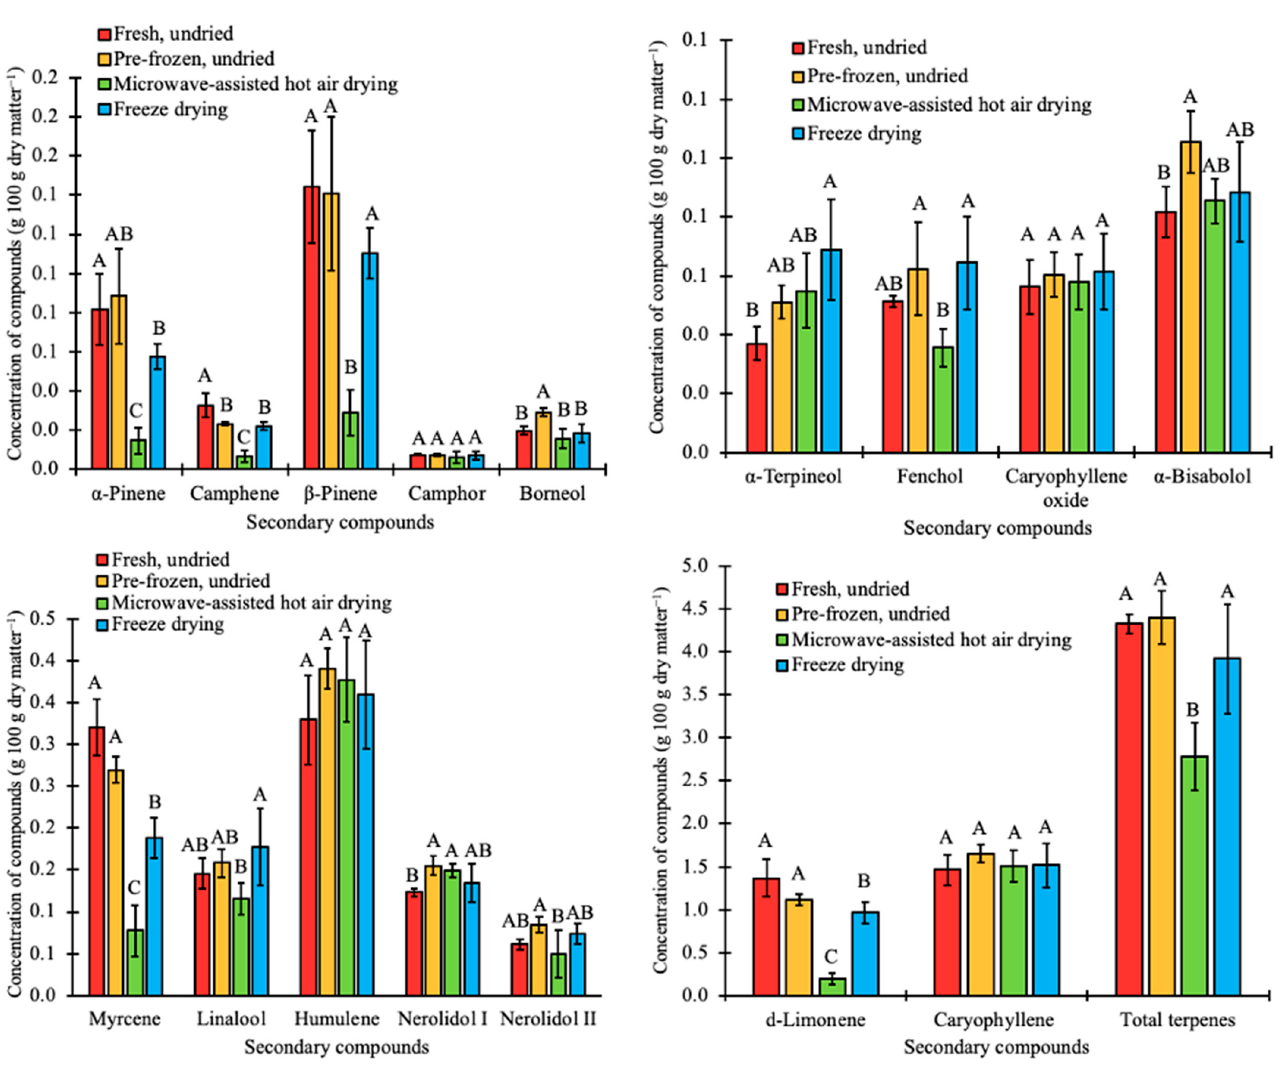
Figure 5. Concentration of terpenes in cannabis in fresh undried, pre-frozen undried, microwave- assisted hot air dried, and freeze-dried cannabis ( C. sativa ) biomass. Bars with the same letter are not significantly ( p < 0.05) different.